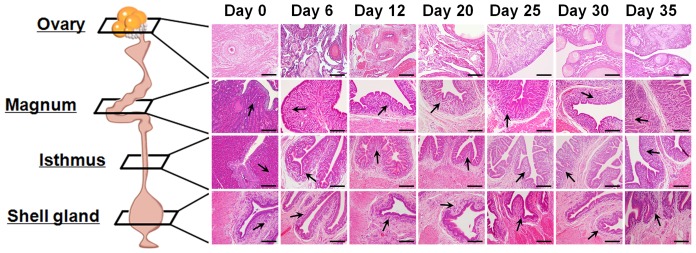
Histological evaluation of ovarian and oviductal tissues at different days of the molting and recrudescence periods.The tissues from the ovary, magnum, isthmus and shell gland were observed following staining with hematoxylin and eosin (H&E). Images were captured at 20× magnification. Arrow: Examples of tubular glands; Scale bar represents 100 µm.